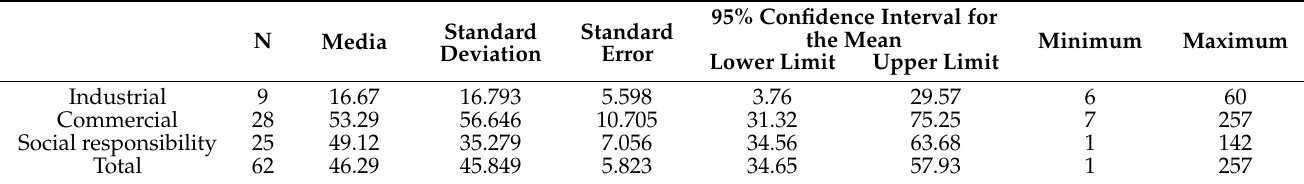
Table 1. Descriptive statistics of share according to brand